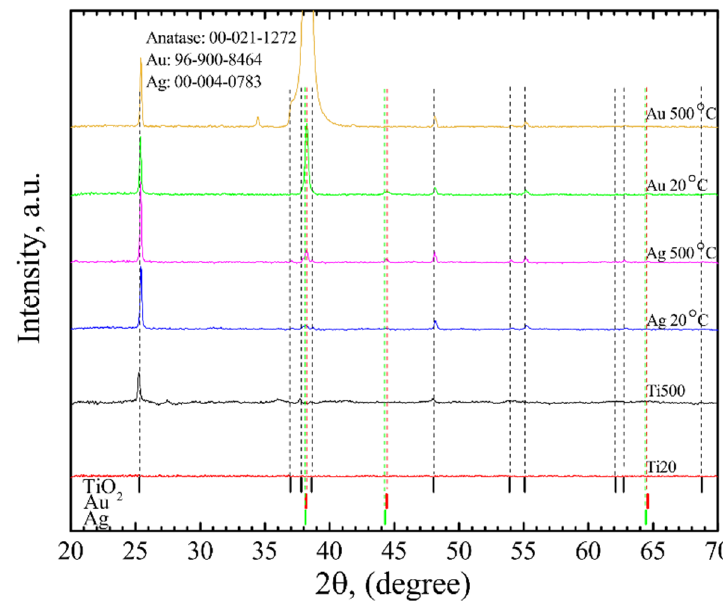
Figure 6. XRD data of AgNP/TiO 2 and AuNP/TiO 2 thin film systems.